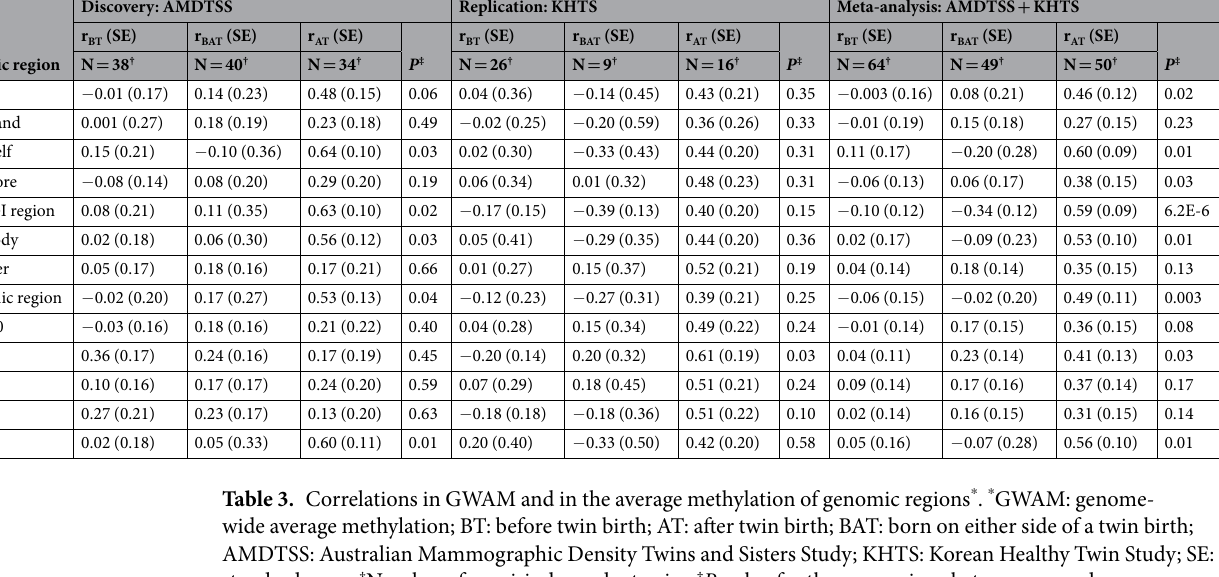
ined factors (all P > 0.1). ence between the two correlations ( P = 0.45; Table 3). BT pairs were not correlated in any other regions (all